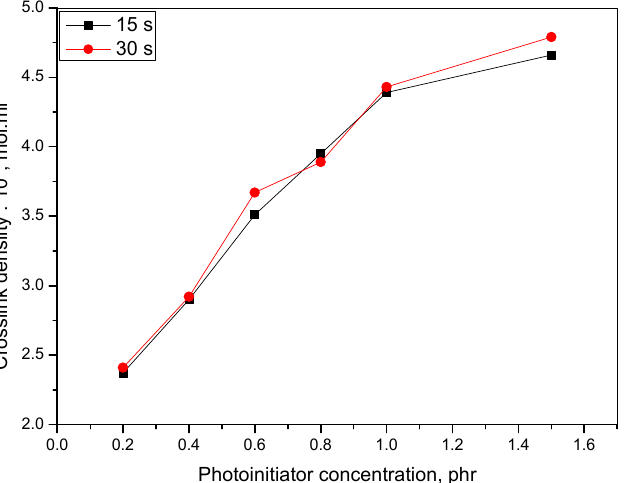
Figure 5. Modulus at 100, 200 and 300% elongations as a function of photoinitiator concentration.